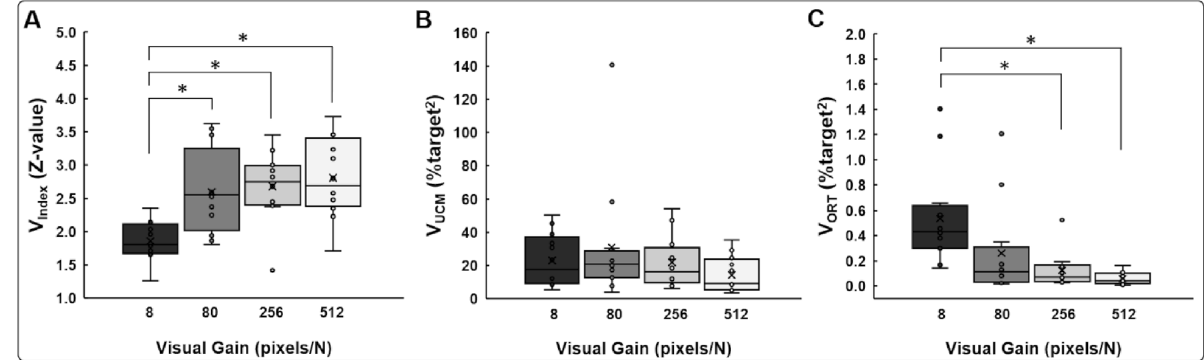
Figure 2. UCM analysis findings. ( A ) Bilateral motor synergies (V Index ) for different visual gain conditions. ( B ) Good variance (V UCM ) for different visual gain conditions. ( C ) Bad variance (V ORT ) for different visual gain conditions. Box plot shows mean (the X inside box), median (the black horizontal line inside box), interquartile range (IQR = Q3 – Q1; top and bottom of box), minimum value: Q1-1.5 × IQR and maximum value: Q1 + 1.5 × IQR (lower and upper error lines), and data falling outside minimum and maximum values (black filled circles). Asterisk (*) indicates a significant difference as comparison with 8 pixels/N ( P < 0.05).